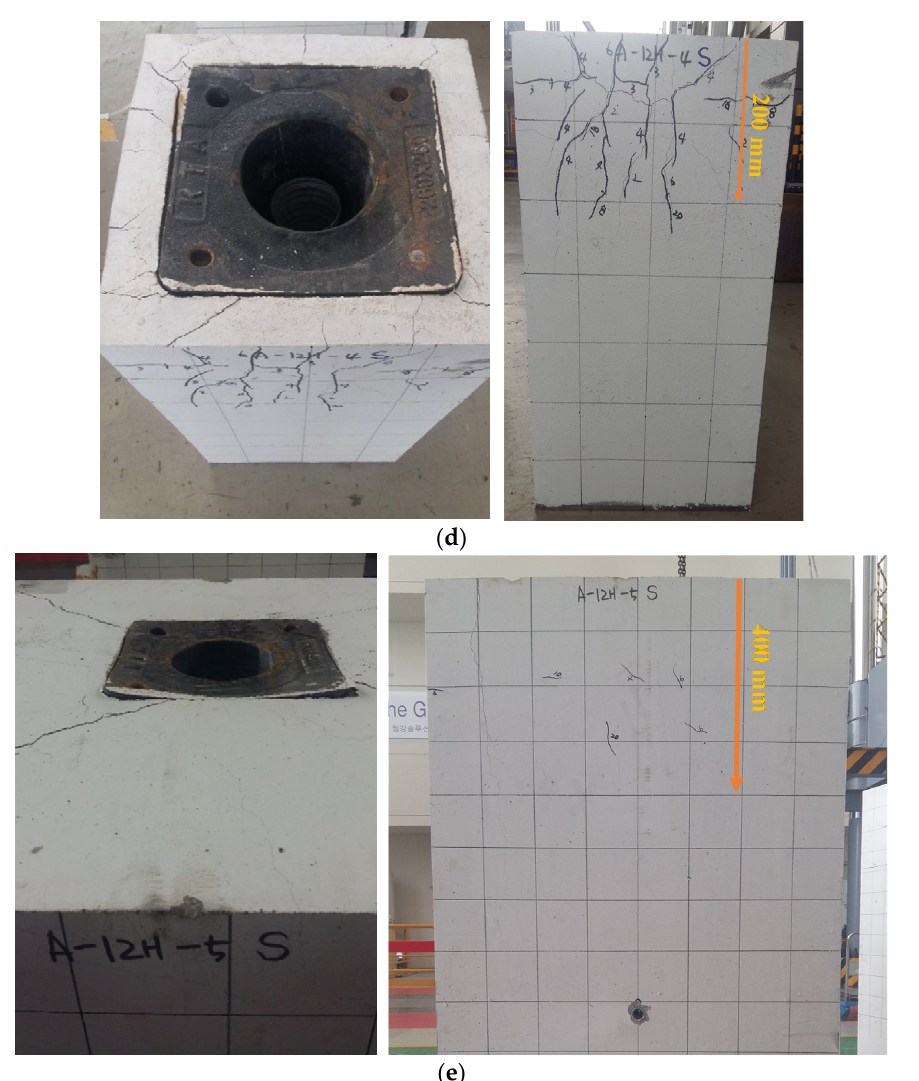
Figure 6. Fracture mode of group 1 specimens: ( a ) A12H-1; ( b ) A12H-2; ( c ) A12H-3; ( d ) A12H-4; ( e ) A12H-5.